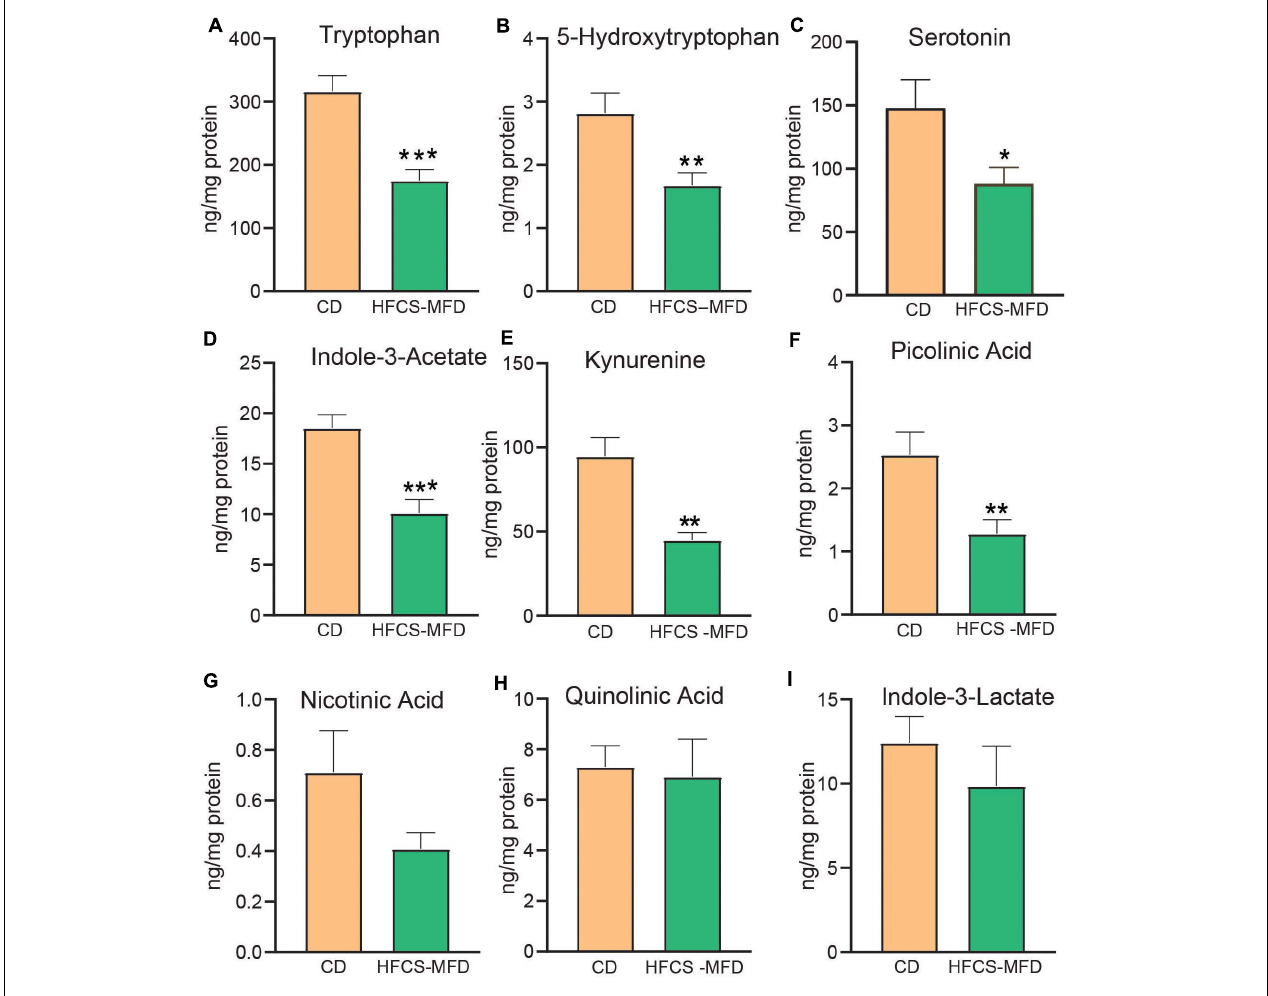
FIGURE 4 | HFCS-MFD dysregulates serum tryptophan metabolism. The effects of the HFCS-MFD vs CD on serum levels of (A) tryptophan, (B) 5-hydroxytryptophan, (C) Serotonin, (D) Indole-3-Acetate, (E) Kynurenine, (F) Picolinic Acid, (G) Nicotinic Acid, (H) , Quinolinic acid and (I) Indole-3-lactate following 16 weeks of diet are shown, ( n = 6 per group; * p < 0.05, ** p < 0.01, *** p < 0.001 unpaired t